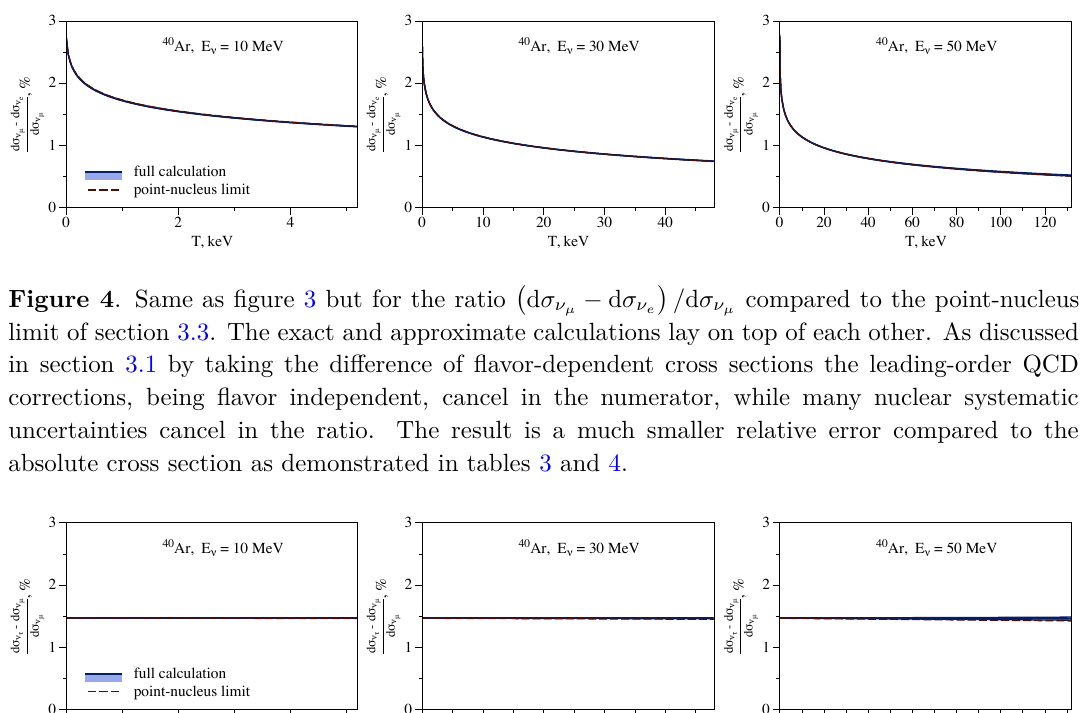
Figure 5 . Same as figure 4 but for the ratio of π DAR arises mainly from closed electron loops and has to be included for flavor differences with electron flavor